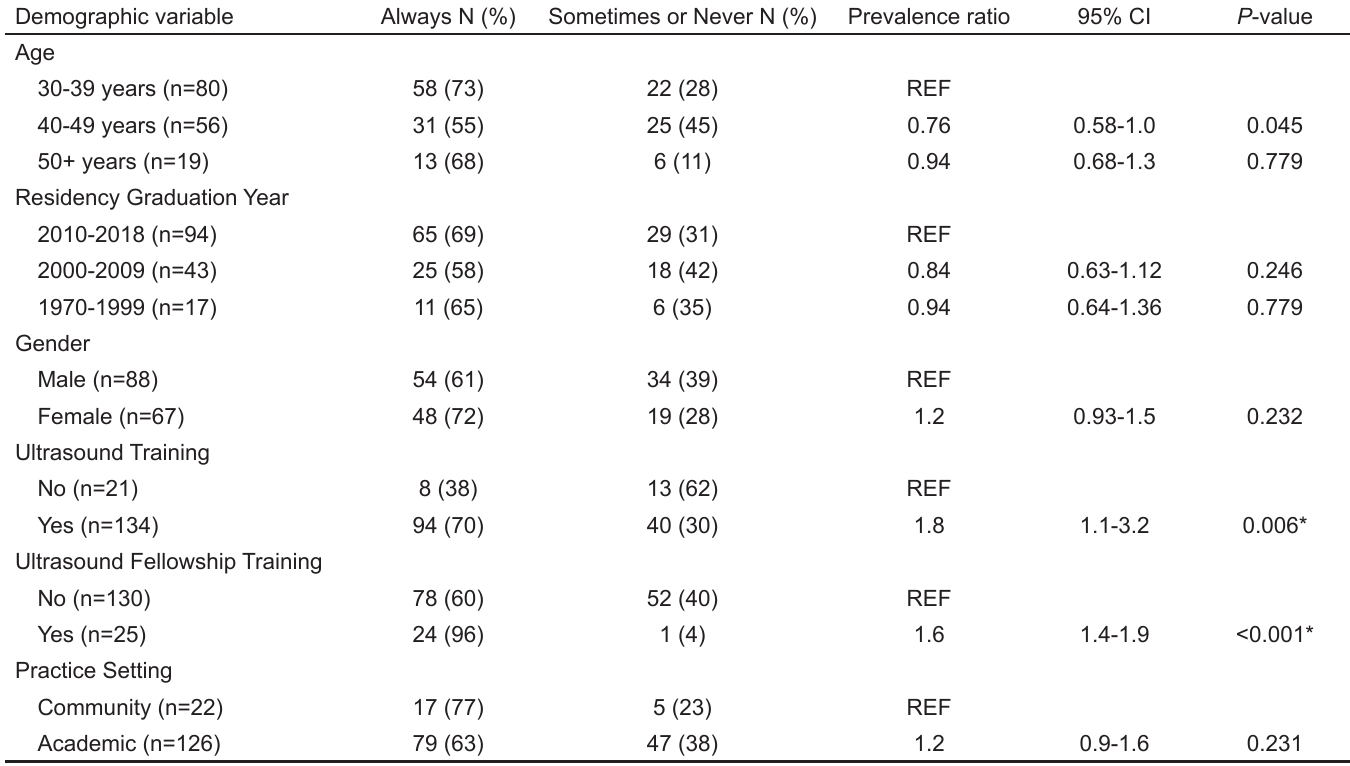
Table 2. Point-of-care echocardiography utilization compared to demographic variables.